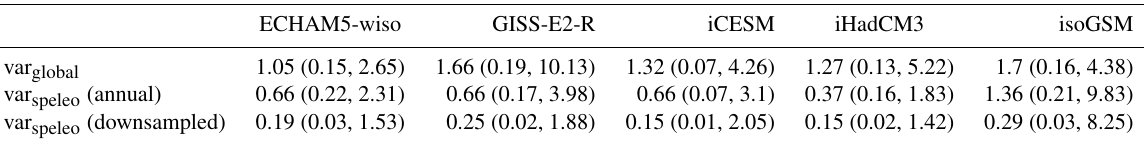
Figure 7. Simulated weighted δ 18 O iw (a–c) , temperature (d–e) , precipitation (g–i) , and evaporation (j–l) against speleothem δ 18 O dweq for model ensemble mean in the tropics, subtropics, and extratropics. The tropical region (23.44 ◦ S to 23.44 ◦ N) is shown in panels (a) , (d) , (g) , and (j) ; the subtropical region (23.44–35 ◦ N/S) is shown in panels (b) , (e) , (h) , and (k) ; and the extratropical region (35–90 ◦ N/S) is shown in panels (c) , (f) , (i) , and (l) . Altitude information is applied as shaded colors in panels (d) – (l) . We use δ 18 O iw for all simulations. Note the semi-logarithmic axes for precipitation and evaporation. Table 2. Area-weighted mean global δ 18 O sim variances as var global with 90% intervals of the distribution are given per simulation. Row two and three give the δ 18 O sim variance at the cave locations in the annual resolution of the simulation and downsampled to the records resolution,